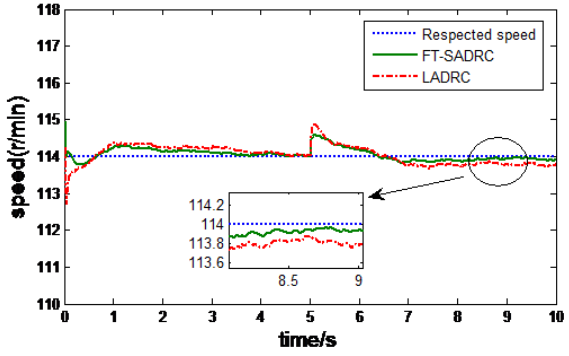
Fig. 2 Curve for the diesel engine speed y .